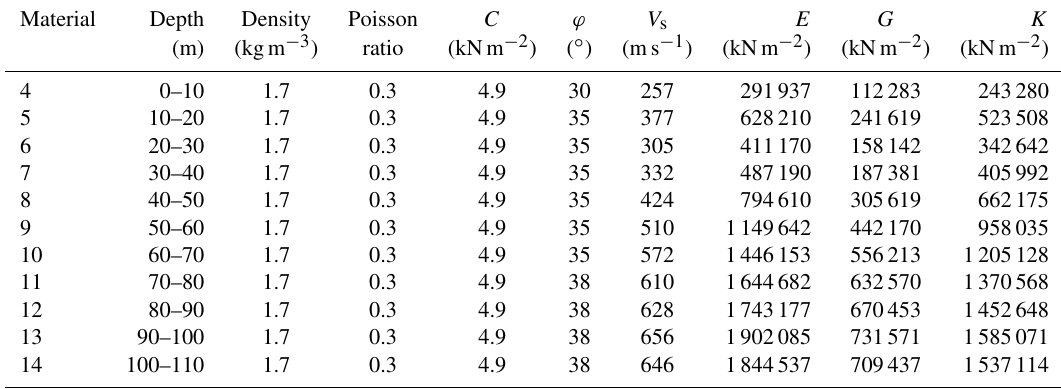
Table 5. Soil characteristics.